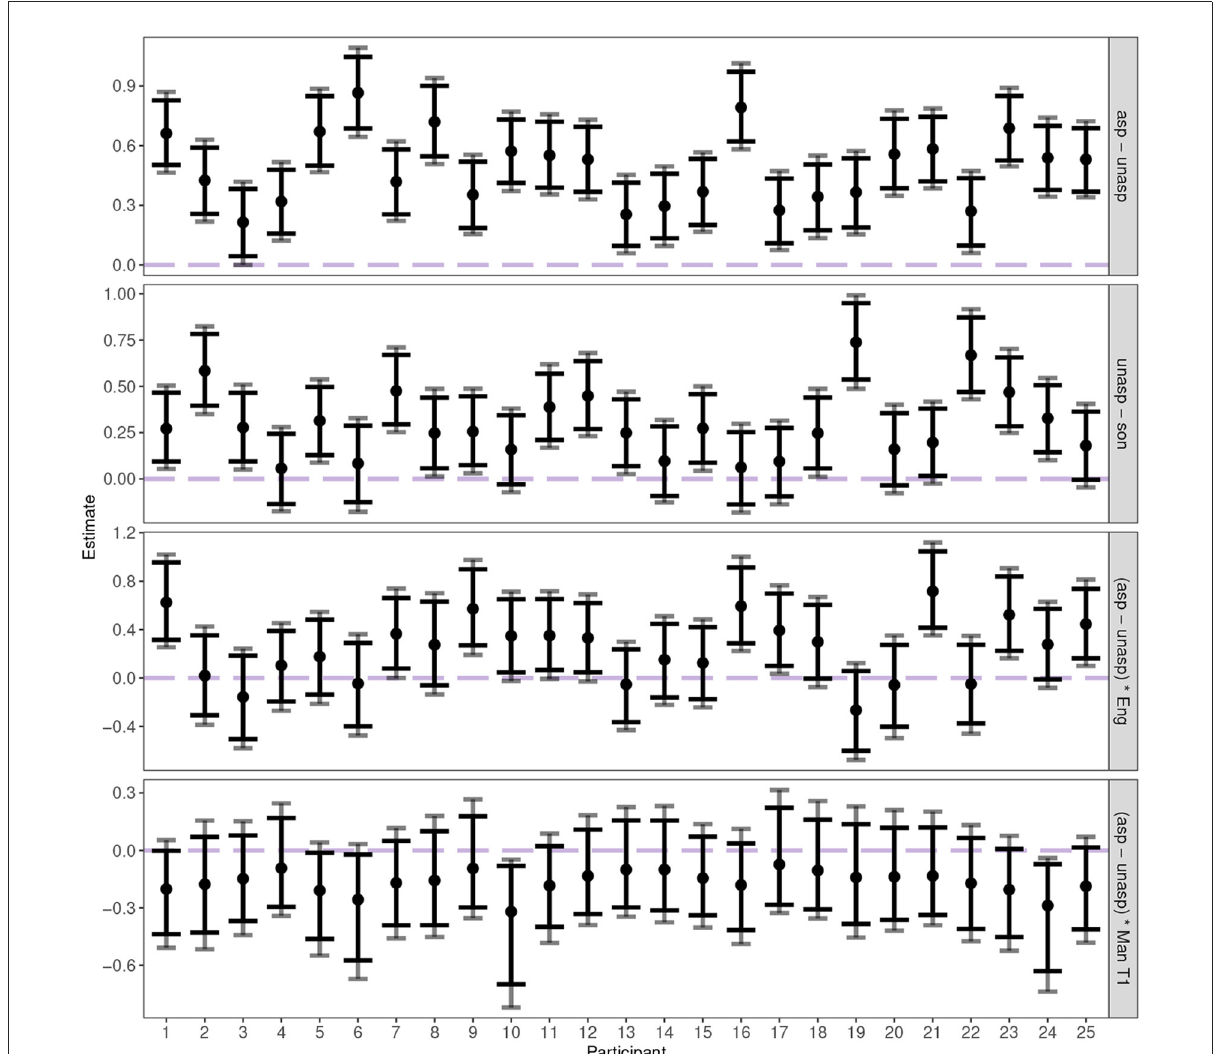
FIGURE2 Marginal posterior summaries for key parameters involving voicing for each individual speaker. The [asp − unasp] panel shows the difference in F0 between aspirated and unaspirated stops. The [unasp − son] panel shows the difference in F0 between unaspirated stops and sonorants. The [(asp − unasp) * Eng] panel shows the further difference in F0 between aspirated and unaspirated stops in English, in comparison to Mandarin. The [(asp − unasp) * Man T1] panel shows the further difference in F0 between aspirated and unaspirated stops in Mandarin Tone 1 tokens, when compared to Tone 4 tokens. The dots denote the posterior means. The inner error bars represent 89% CrIs, and the outer error bars represent 95%